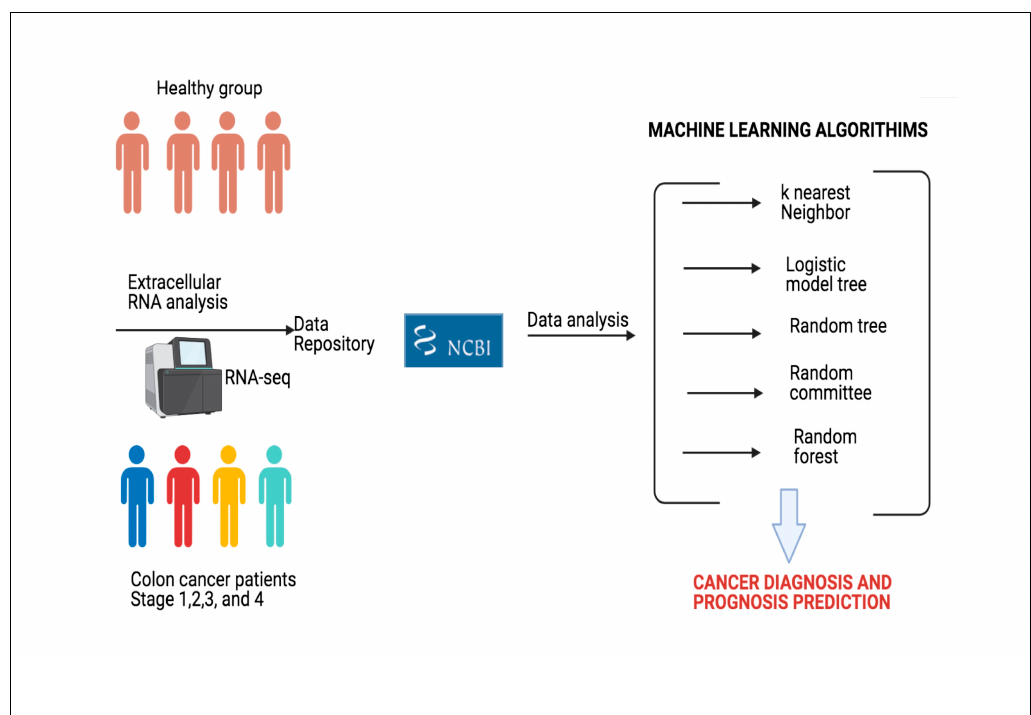
Figure 1. The general framework of proposed approach. (Illustrations by the authors).